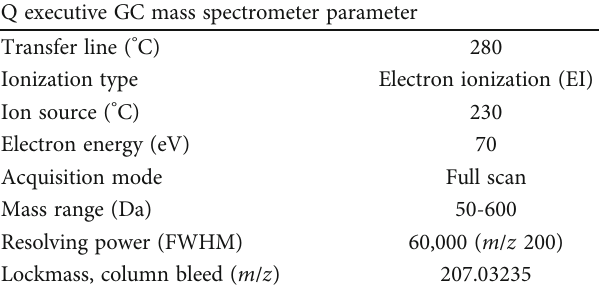
Table 3: Mass spectrometer